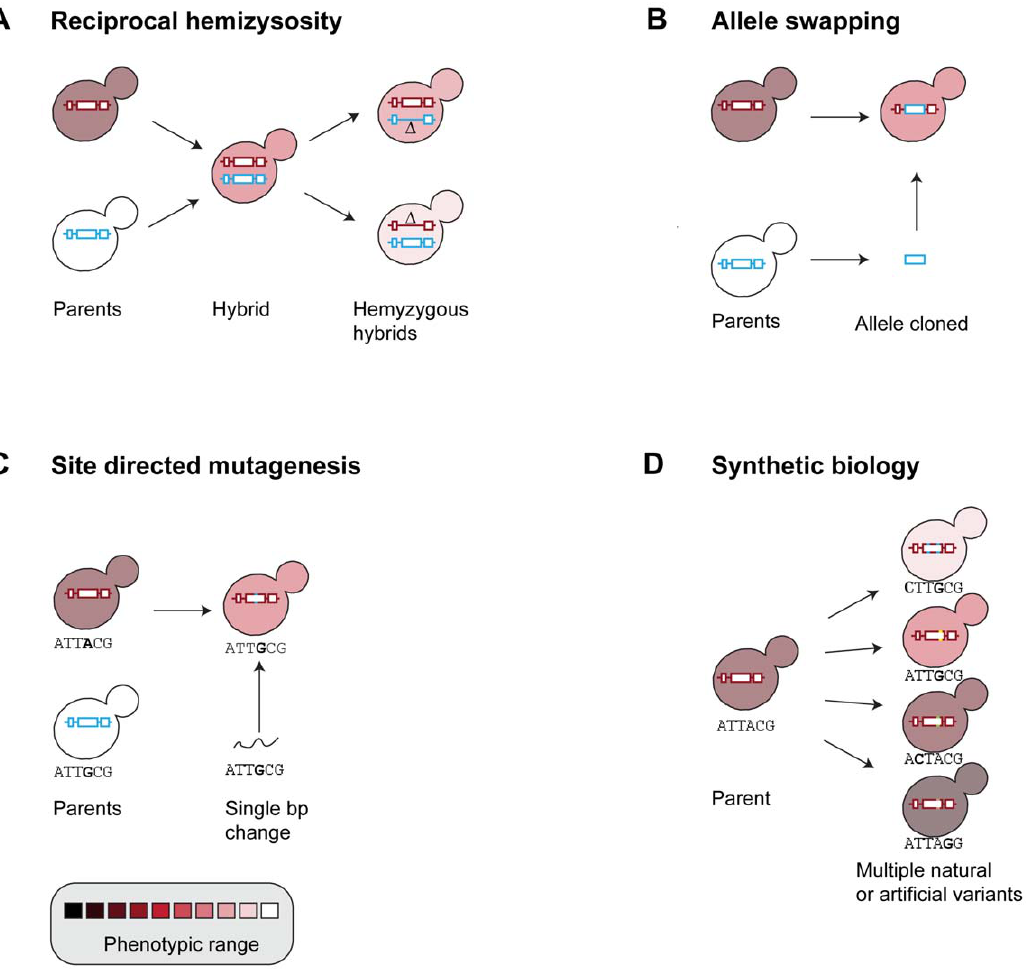
Figure 1. Experimental measures of natural variation. Yeasts offer a unique opportunity to engineer changes to measure the impact of phenotypic variants on traits. (A) Reciprocal hemizygosity has high throughput and can be used to test a large number of candidates. Hybrids that differ only in which of two alleles is present/deleted are compared. Deletion collections of multiple strains will soon be available allowing genome- wide systematic studies using hybrids to test all candidates easily or even for discovery of phenotypic effects directly. (B) Allele swapping is less high throughput but allows testing phenotypic effects of specific alleles in different genetic backgrounds. This is more precise than reciprocal hemizygosity. (C) Site-directed mutagenesis is a rapid and precise way of testing known and novel base changes for phenotypic effects. (D) Synthetic biology has the potential of simultaneously testing multiple variants, both natural or artificial, in a single gene [55] or scattered through the genome